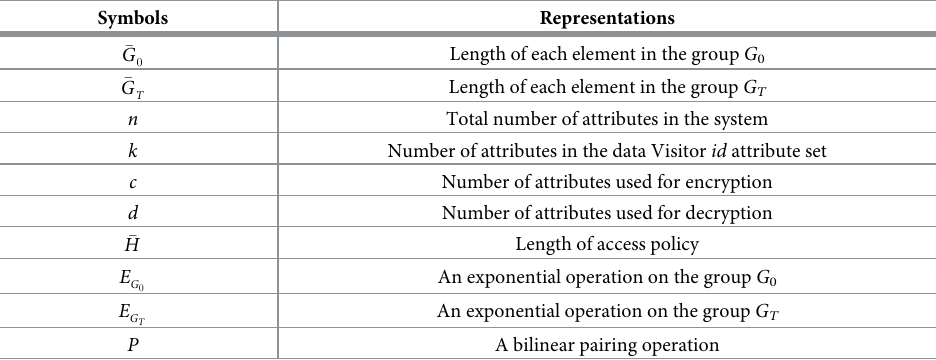
Table 1. Notations adopted in our paper.